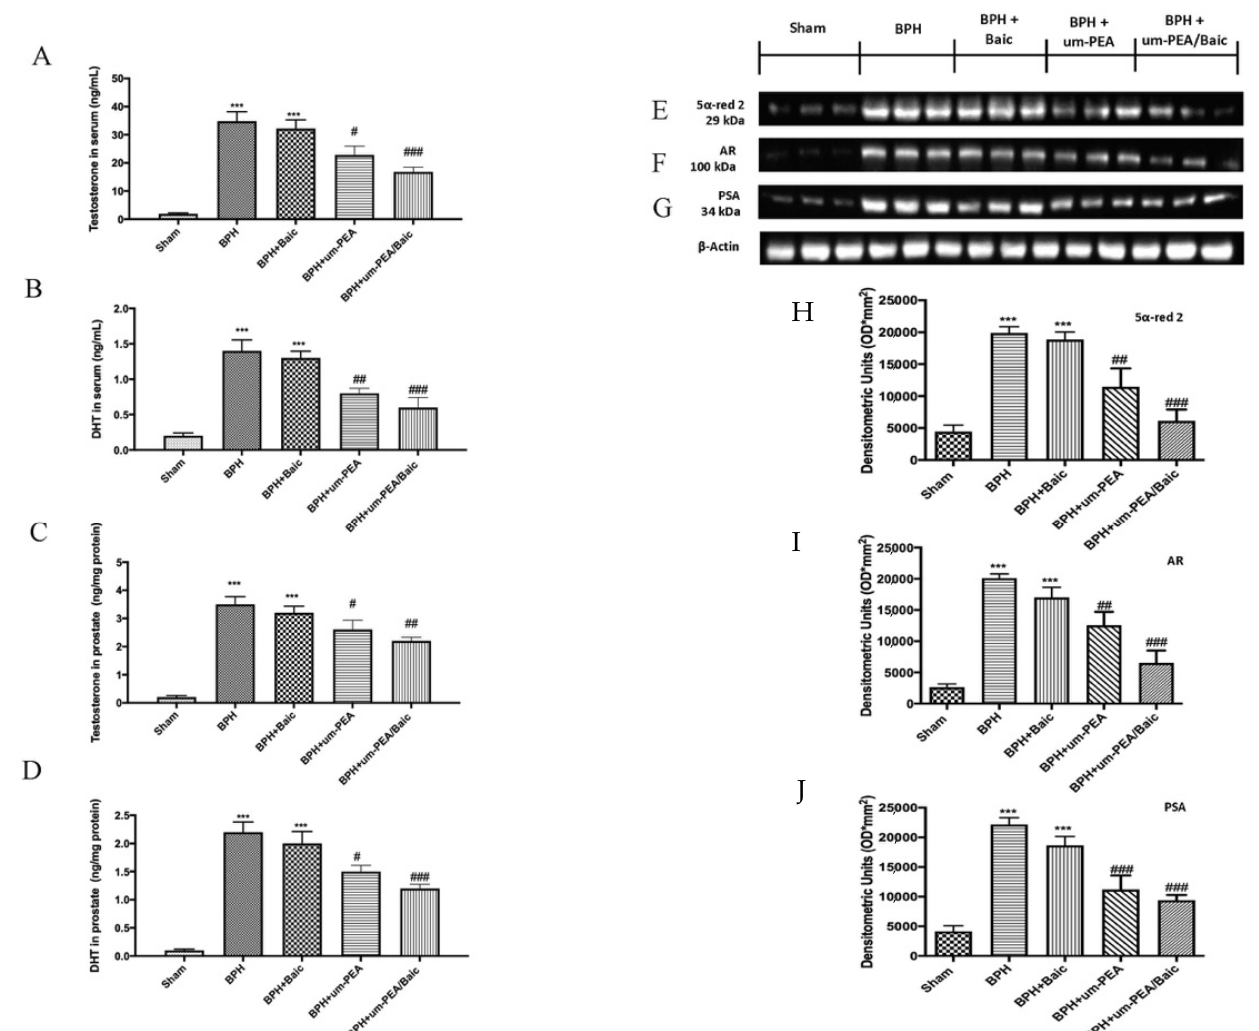
Figure 1. Effect of um-PEA/Baic on testosterone and DHT levels and 5 α -red 2, AR and PSA expression. Testosterone levels in serum ( A ); DTH levels in serum ( B ); testosterone levels in prostate ( C ); DTH levels in prostate ( D ); Western blots and densitometric analysis of 5 α -red 2 ( E , H ), AR ( F , I ) and PSA ( G , J ). A demonstrative blot of lysates with a densitometric analysis for all animals is shown. Values shown are means ± SEM of six animals in each group. *** p < 0.001 vs. sham; # p < 0.05 vs. BPH group; ## p < 0.01 vs. BPH group; ### p < 0.001 vs. BPH group.